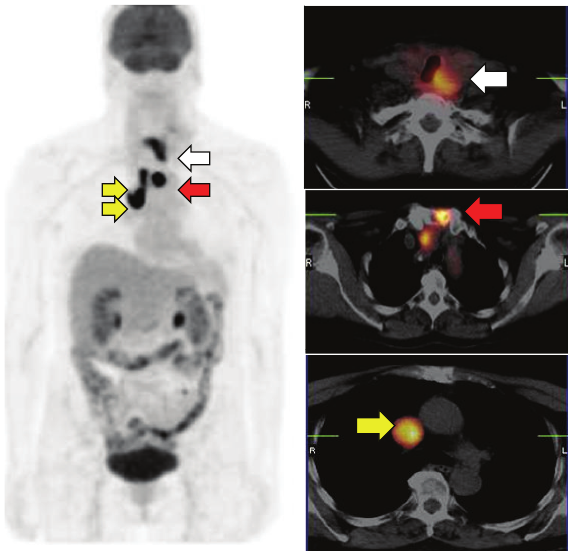
Figure 2: FDG-PET/CT in a 58-year-old female with ATC showing the presence of increased uptake in the thyroid tumour (white arrow) and sternal (red arrows) and mediastinal lymph nodal metastases (yellow arrows).